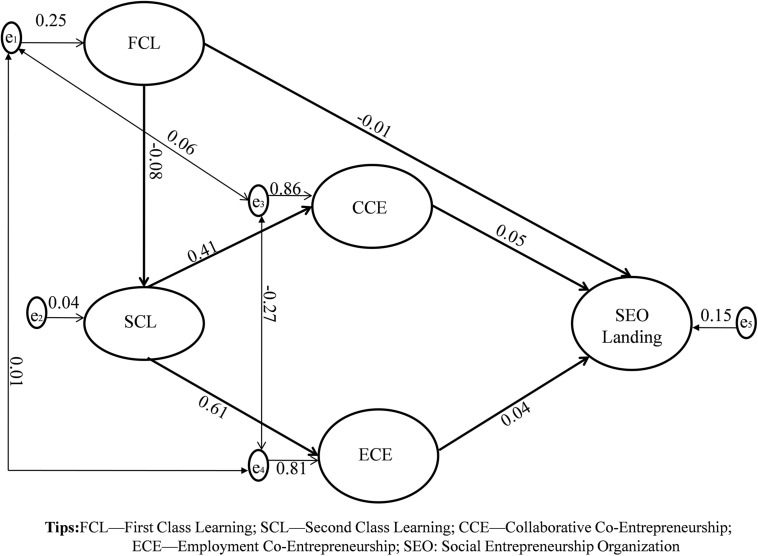
The mechanism of SEO launching under the TSCE cultivation model. The data results are from the analysis of 583 articles with the title of “social entrepreneurship” in the period of 1998–2018 by CiteSpace 5.3.r3 to web of Science (Core Collection).